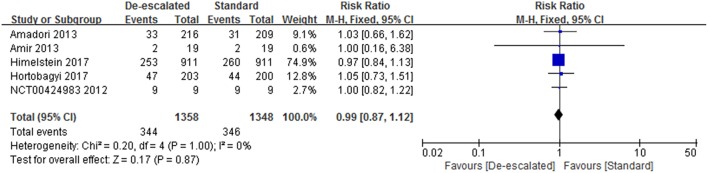
Meta-analysis result of SREs.